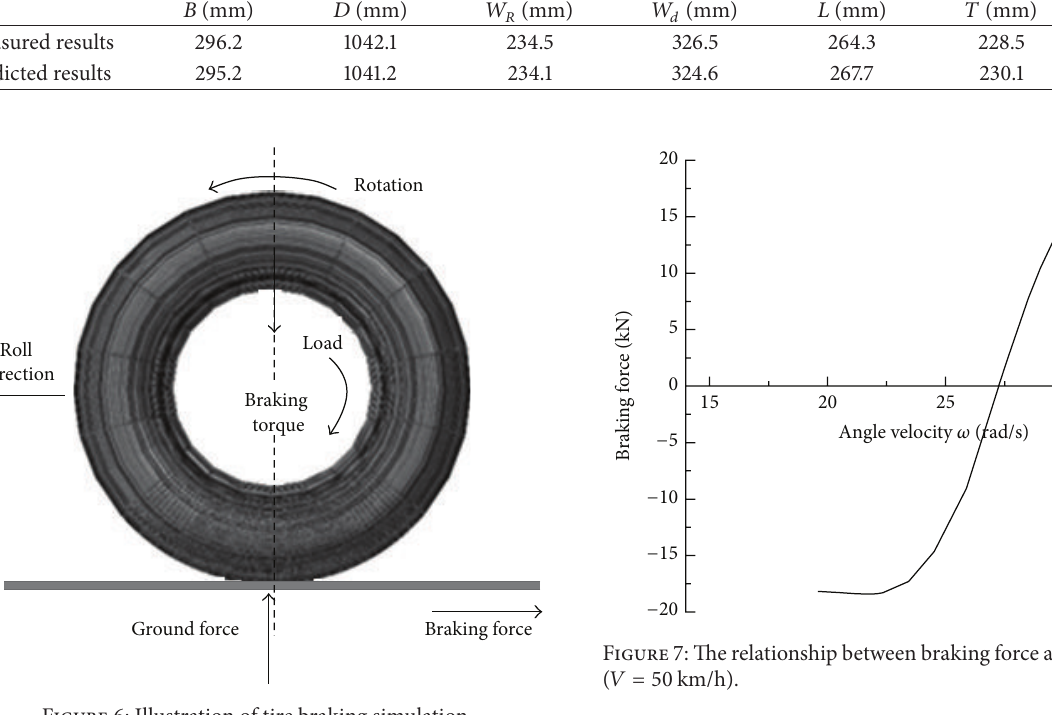
Table 1: Comparison of the predicted results with measurement. (Inflation section width 𝐵 , inflation outer diameter 𝐷 , inflation tread width 𝑊 𝑊 𝑅 , the largest deformed section width 𝑑 , the length and width of the contact patch denoted as